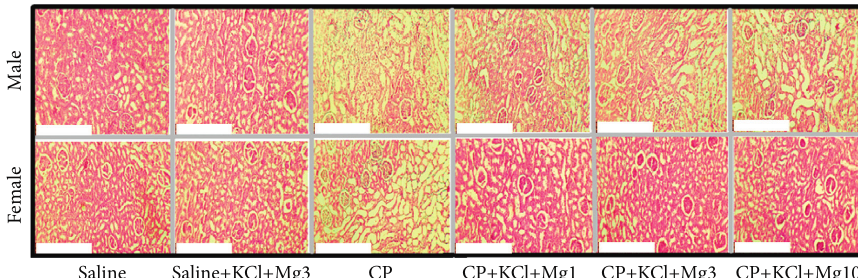
Figure 2: The sample images ( × 100) of kidney tissues in 12 groups of experiments including saline, saline+KCl+Mg3, CP, CP+ KCl+ MgSO 4 , CP +KCl+Mg1, CP+KCL+ Mg3, and CP +KCl+Mg10 (see Table 1 for groups’ details). More damages were seen in the CP-treated group when compared with non-CP-treated groups. The score of damage tissue in the female group treated with CP+ KCl+ Mg3 was less than the similar treated group of male. The white bar corresponds to 0.25mm ×